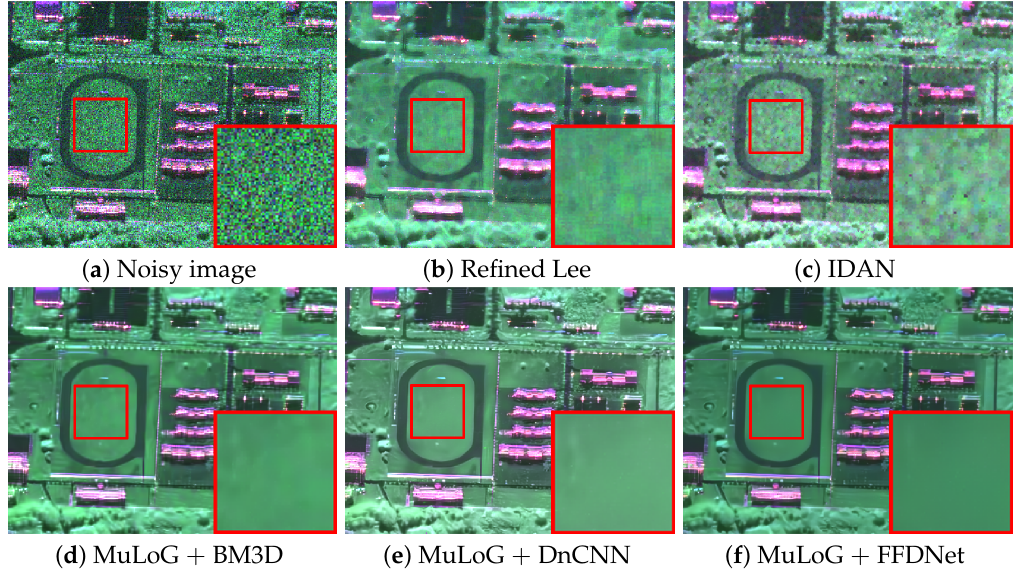
Figure 15. The denoising results for CETC-38th airborne SAR with L = 1: ( a – f ) Noisy image, Refined Lee, IDAN, MuLoG + BM3D, MuLoG + DnCNN, and MuLoG + FFDNet,